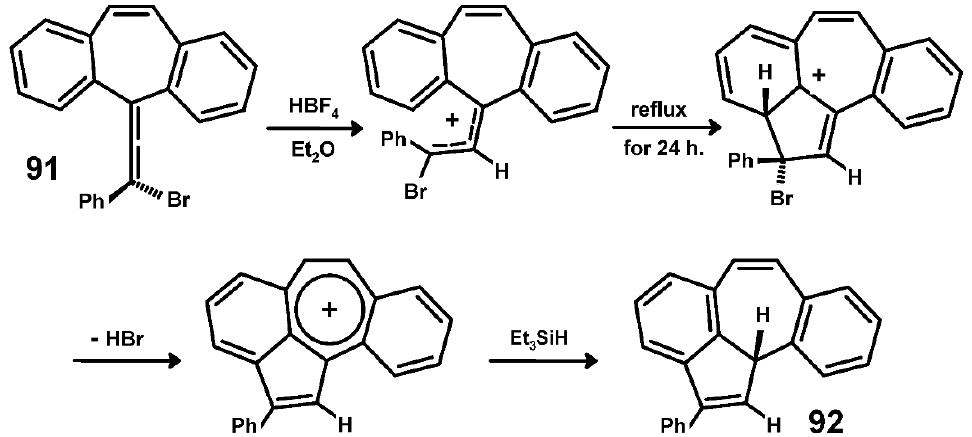
Figure 12. Molecular structure of 2-phenyl-11b H -dibenz[ cd , h ]azulene, 92. 6. Serendipitous Formation of Tetracenes from 9-Phenylethynyl-9 H -fluorene